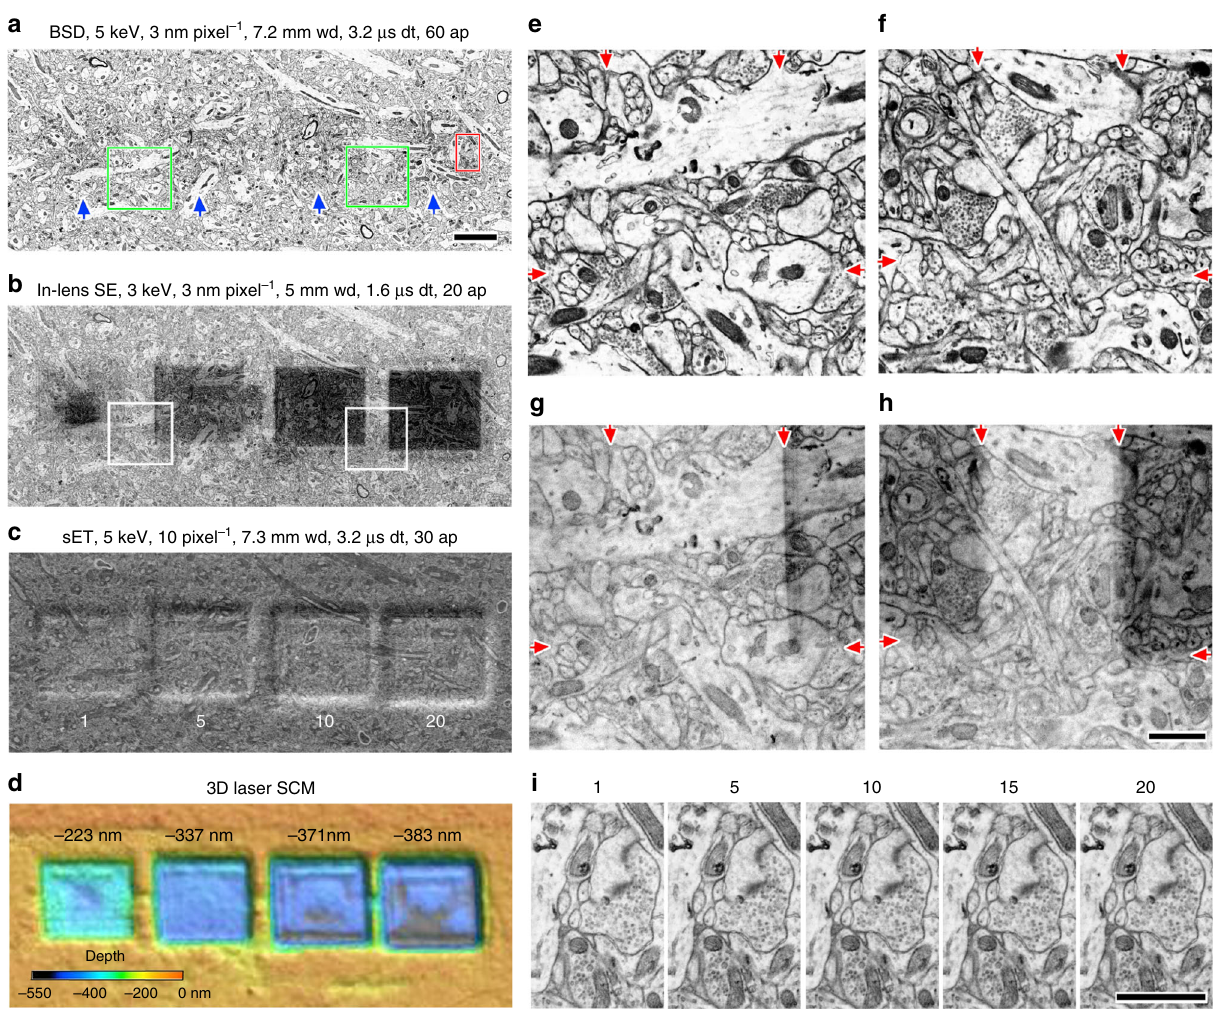
Fig. 3 Repeated image capturing does not substantially affect image quality. a Image of the mHMS ultrathin section of cortex captured with BSD for 3.2 µ s dwell time, 3 nm pixel − 1 , 60 μ m aperture at 5 keV, 2.8 ke − nm − 2 electron dose, where the 2048×2048 image size, 3.2 µ s dwell time, 3 nm pixel − 1 , 60 μ m aperture at 5 keV had been captured one, 5, 10 and 20 times indicated by blue arrows from left to right. Scale, 3 µ m, is also for b – d . b Image of the same location of a captured with an In-lens SE detector for 1.6 µ s dwell time, 3 nm pixel − 1 , 20 μ m aperture at 3 keV. Darker squares correspond with the pre- imaged area. c The same area imaged with the ETD. The imaging times are indicated below the depression square. d The surface pro fi le image. Depression depth is indicated above the depression square. e . Enlarged image of left green square in a . Arrows on the top left and middle left indicate the border of the once imaged area. Arrows on the top right and middle right indicate the border of the area imaged 5 times. f Enlarged image of right green square in a . Arrows on the top left and middle left indicate the border of the area imaged 10 times. Arrows on the top right and middle right indicate the border of the area imaged 20 times. g Enlarged image of left square in b . Arrows indicate the border shown in e . h Enlarged image of right square in b . Arrows indicate the border shown in f . Scale, 1 µ m, is also for e – g . i Enlarged image of red rectangle in a . The number of imaging times are shown above the images. Scale, 1 µ m. wd, working distance; dt, dwell time; ap, labeling was speci fi c to inhibitory neuronal pro fi les (Fig. 4f – i, wavelength. The CNT tape is transparent (Supplementary Fig. 2) Supplementary Movie 1) and con fi rmed the capability of and has no auto- fl uorescence when excited by yellow-green ( λ = immunoreactions using CNT tape. We also examined serial thin 561 nm) or red light ( λ = 633 nm), only a very faint auto- fl uorescence when excited with blue light ( λ = 488 nm), and sections with the immuno fl uorescent method and found GABA- positive fl uorescent immunoreactivity (Fig. 4j, k). On the other slightly more with purple light ( λ = 405 nm) (Fig. 4a). Absorption hand, because cc-Kapton tape is yellowish-brown in color was low overall (Fig. 4b), with a light transmittance of about 80% (Supplementary Fig. 2) and showed signi fi cant auto- (Fig. 4c), total light transmittance of 88.4% (Fig. 4d) and haze of fl uorescence in all emission light wavelengths (Fig. 4a), the light 1.9% (Fig. 4e). Therefore, the tape can be used for multi-color fl uorescent immunohistochemistry or array tomography 40 except transmittance was lower than the CNT tape (Fig. 4c) and the total for excitation with violet light. light transmittance was 47.9% (Fig. 4d). We performed GABA post-embedding immunoreactions on ultrathin sections on cc- Kapton tape and found no immunoreactivity, with many non- speci fi c gold particles on the surface of the cc-Kapton tape. Probably the carbon on the cc-Kapton tape restored adsorptive capacity by thermal reactivation during the carbon evaporation